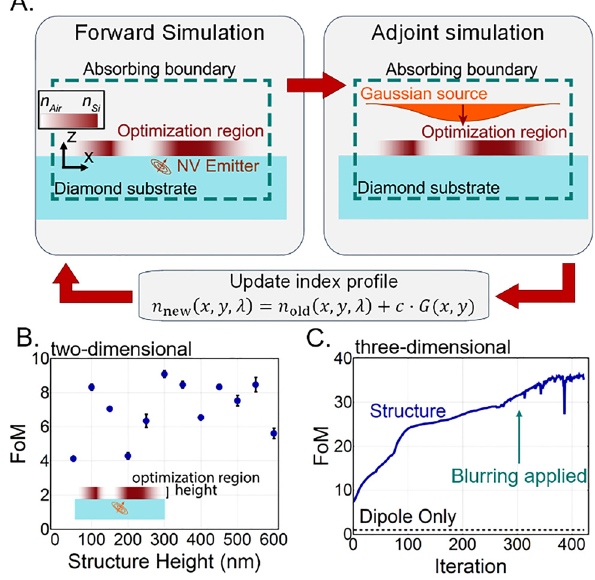
Figure 2: (A) Visualization of the optimization routine, which evolvesanindexprofilesituatedaboveanNVemitter.Intheforward simulation, the light source is a dipole at the location of the NV. The sources in the adjoint simulations are two orthogonally polarized Gaussian beams injected from free space toward the structure. The sensitivity gradient, G ( r ) (cid:1) G ( x , y ) , is calculated and then used to evolve the index pro fi le. The updated pro fi le is then used in the next iteration. (B) A sweep of the structure height (i.e., the thickness of the Si membrane), running fi ve full 2D optimization cycles for each height. We found a height of approximately 300 nm to be optimal over the rangeof the sweep.The error barsrepresentthe varianceat eachheight.Thevarianceisverysmallforsomeheights,sotheerror bars are not visible. (C) FoM vs. the iteration number for a full 3D optimization run to generate our NLE. The dips are due to the application of the secondary blurring later in the optimization. FoM, fi